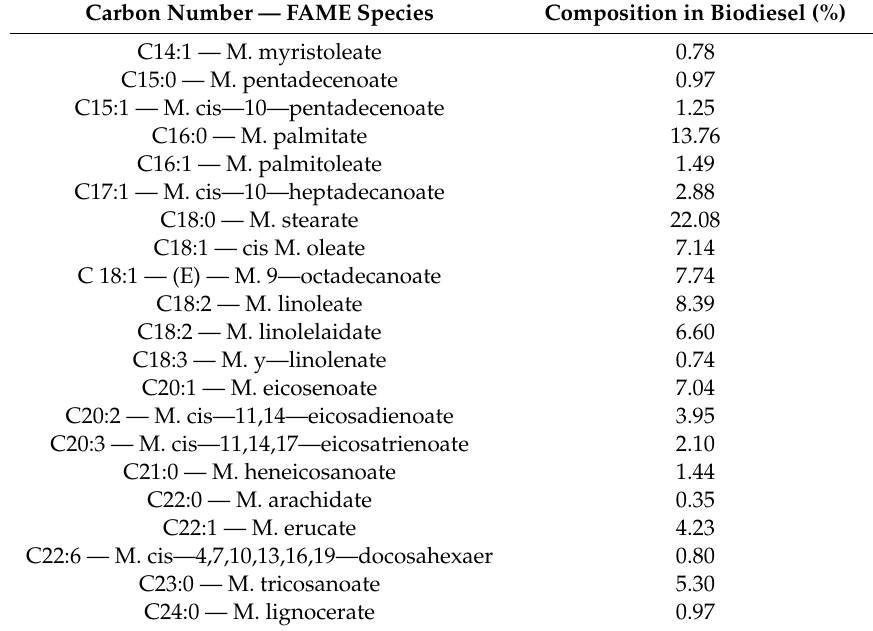
Table 2. The fatty acid methyl ester (FAME) profile of biodiesel from microalgal biomass harvested via adsorption-enhanced flocculation